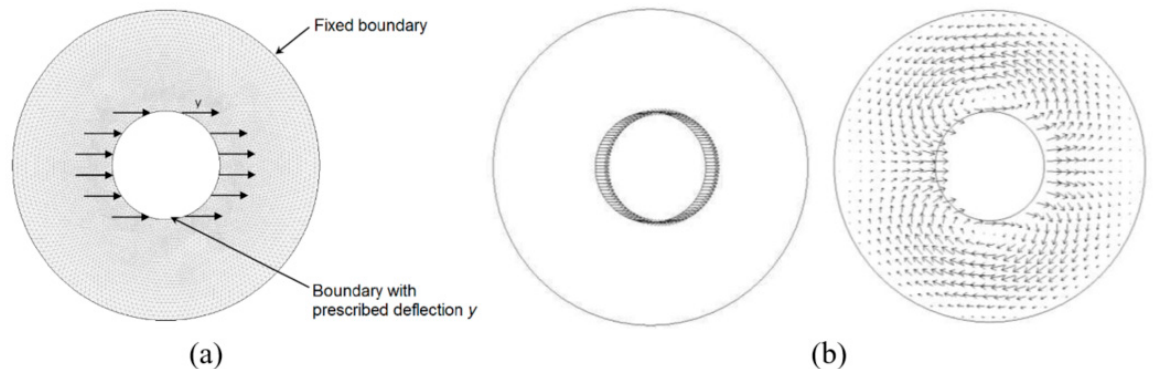
Figure 40. Numerical model used for evaluation of scaling factors Ms and Ns: ( a ) mesh used in FE model; ( b ) typical deformation mechanism.